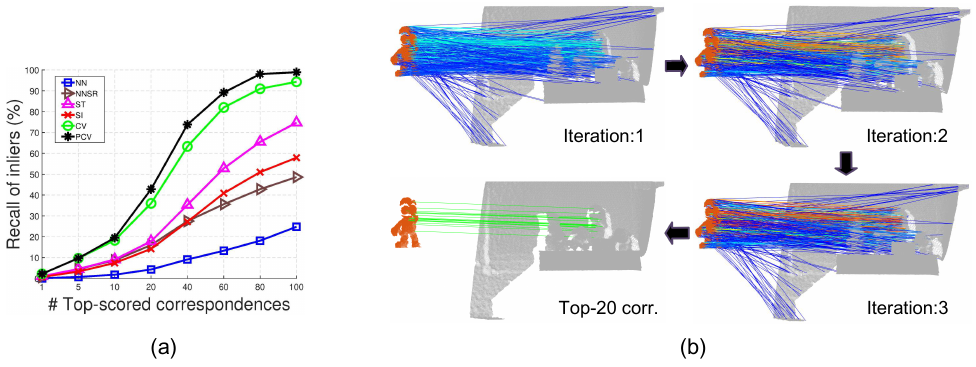
Figure 7. Feature matching results on the BoD5 dataset. ( a ) The ROI performance of six tested methods. ( b ) Visualization of the scoring result at each iteration of PCV (voting scores are encoded with